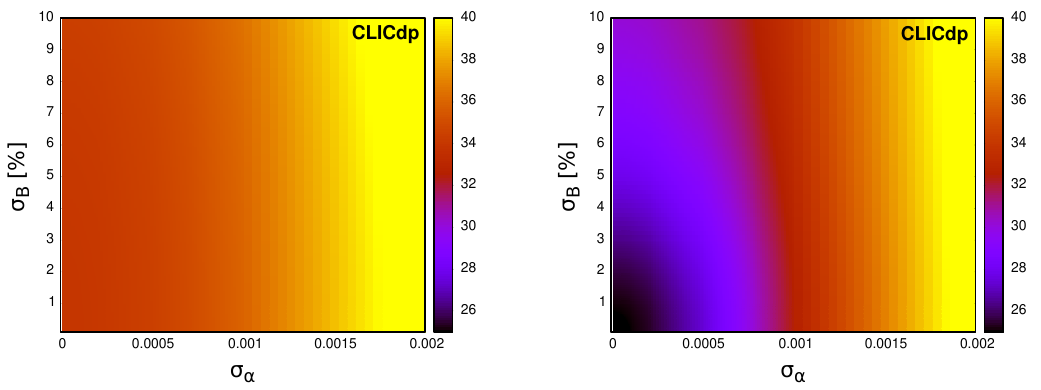
Figure 7 . Expected uncertainty on the top-quark mass as a function of the uncertainty of the strong coupling constant and the background level uncertainty. Results from the fit of all model parameters (5D) are presented with no constraint on the top Yukawa coupling (left) and for the assumed Yukawa uncertainty of σ = 0 . 1 (right). Normalisation uncertainty, ∆ = 1% , is assumed. y t Colour maps are obtained using a linear interpolation